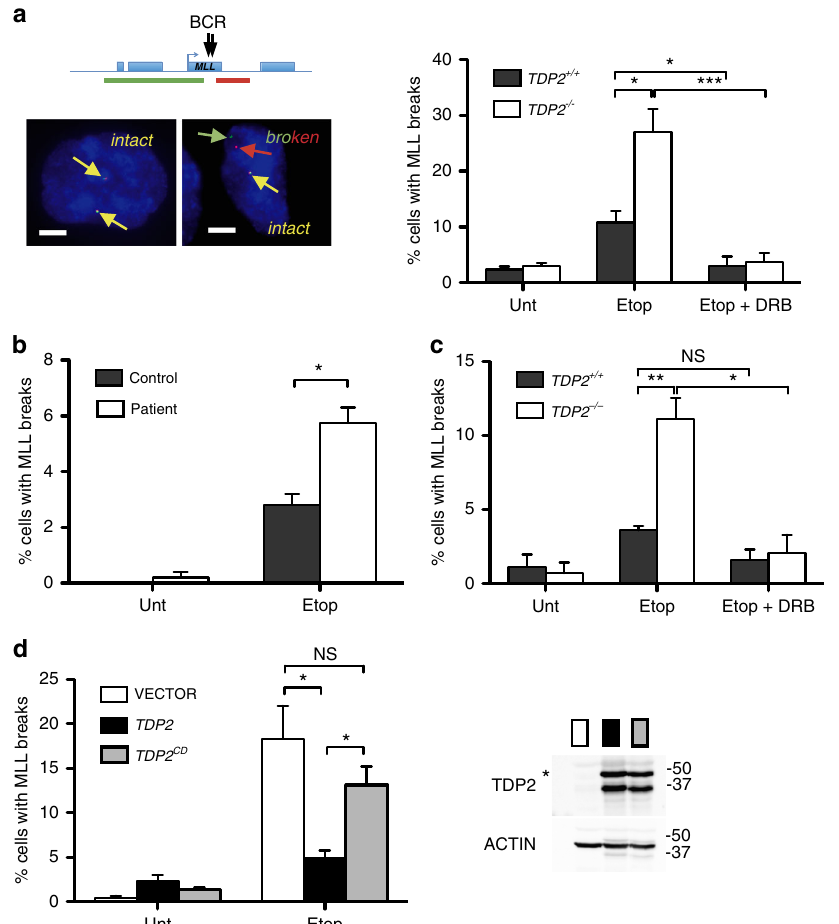
Fig. 3 TDP2 is required for the repair of TOP2-induced DSBs at MLL . a Detection of broken MLL loci by FISH in wild-type and TDP2 − / − RPE-1 cells following mock-treatment or treatment with 100 µ M etoposide for 6 h. Where indicated, cells were pre-incubated with DRB (100 µ M) for 3 h prior to etoposide treatment. Left , representative images of intact ( yellow ) and broken ( red and green ) MLL loci ( Scale bar 5 µ m). The position of the FISH probes ( red and green lines in top cartoon) fl anking the MLL breakpoint cluster are shown. Right , data are the mean ( ± s.e.m.) of three independent experiments. Statistical signi fi cance was measured by T -tests (* P < 0.05, ** P < 0.005, *** P < 0.001). b Detection of broken MLL loci in normal and TDP2 patient lymphoblastoid cells, measured as above. Data are the mean ( ± s.e.m.) of two independent experiments. c Detection of broken MLL loci by FISH in serum-starved wild-type and TDP2 − / − RPE-1 cells. Data as in a . d Detection of broken MLL loci by FISH in TDP2 − / − RPE-1 cells infected with either empty lentiviral vector or vector expressing either wild-type TDP2 ( TDP2 ) or catalytic mutant TDP2 D262A ( TDP2 CD ). Data as in a . See inset for levels of TDP2 protein (full-length TDP2 is indicated by an asterisk). Molecular weight markers in